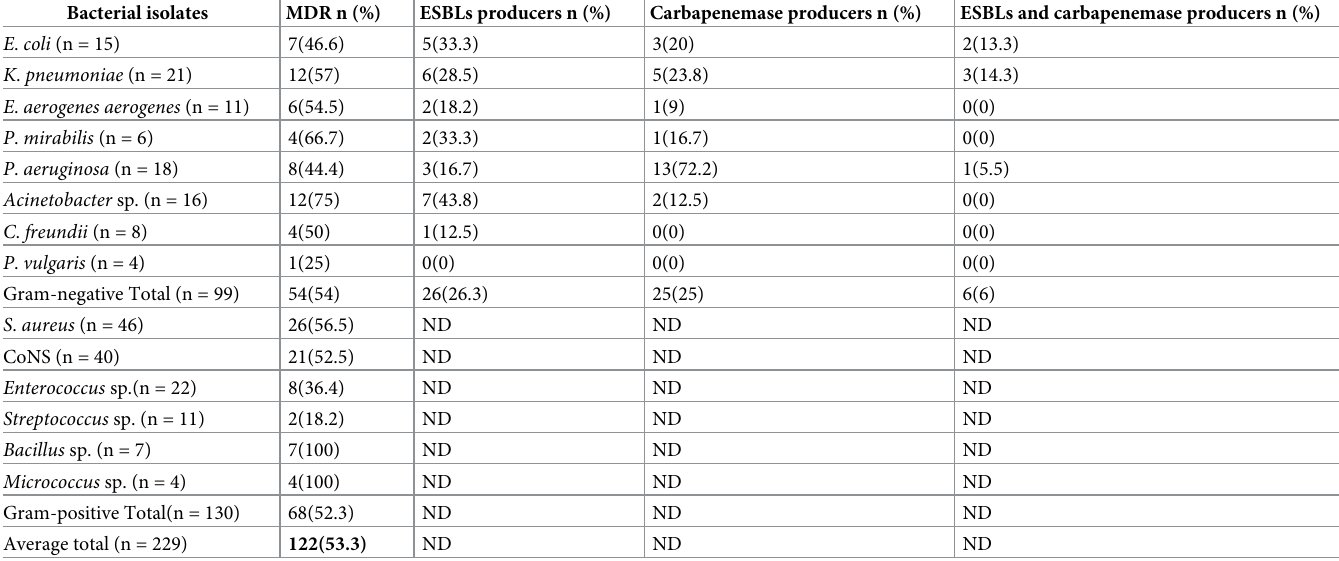
Table 6. MDR, ESBLs and carbapenemase enzyme production patterns of Gram-negative isolates. Bacterial